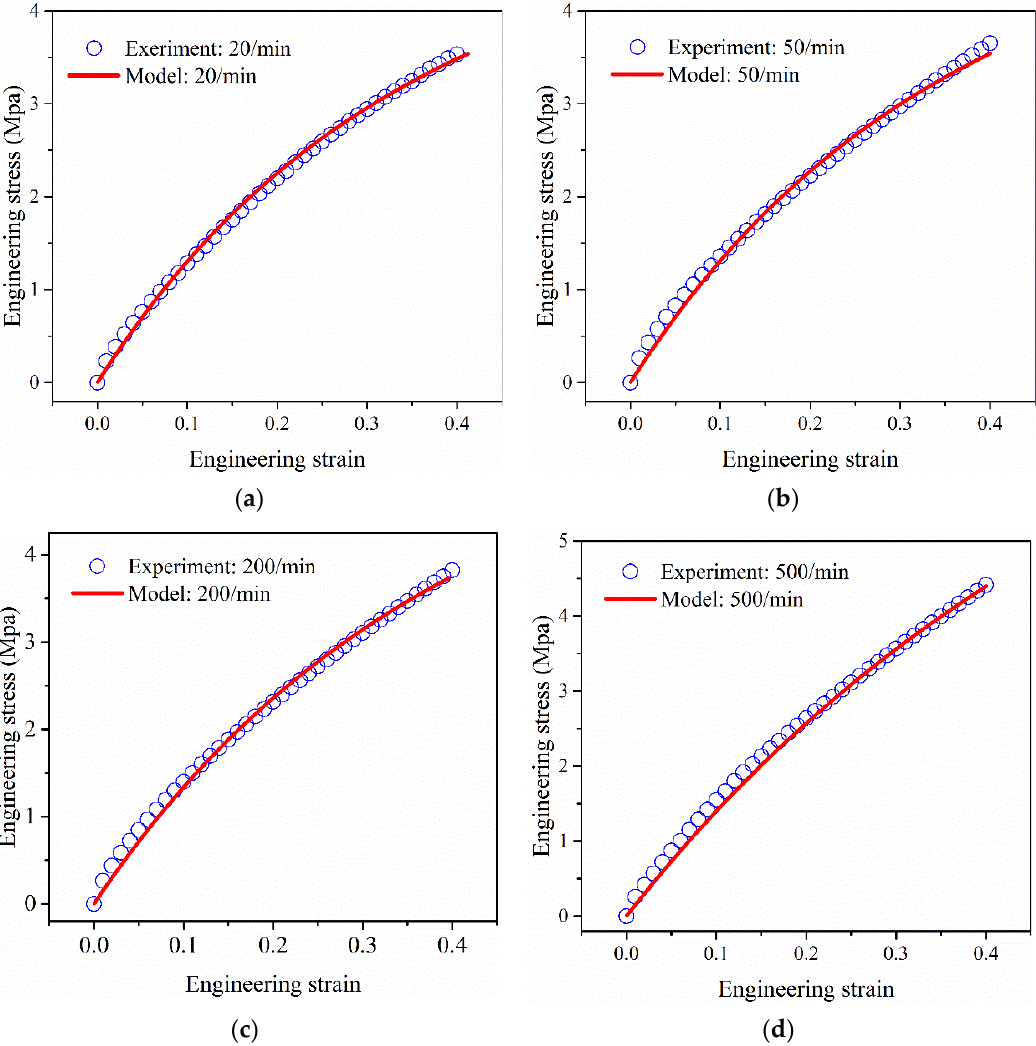
Figure 1. Comparison of the experimental data and prediction results obtained from the proposed model at different stretch rates, ( a ) 20/min, ( b ) 50/min, ( c ) 200/min, ( d )